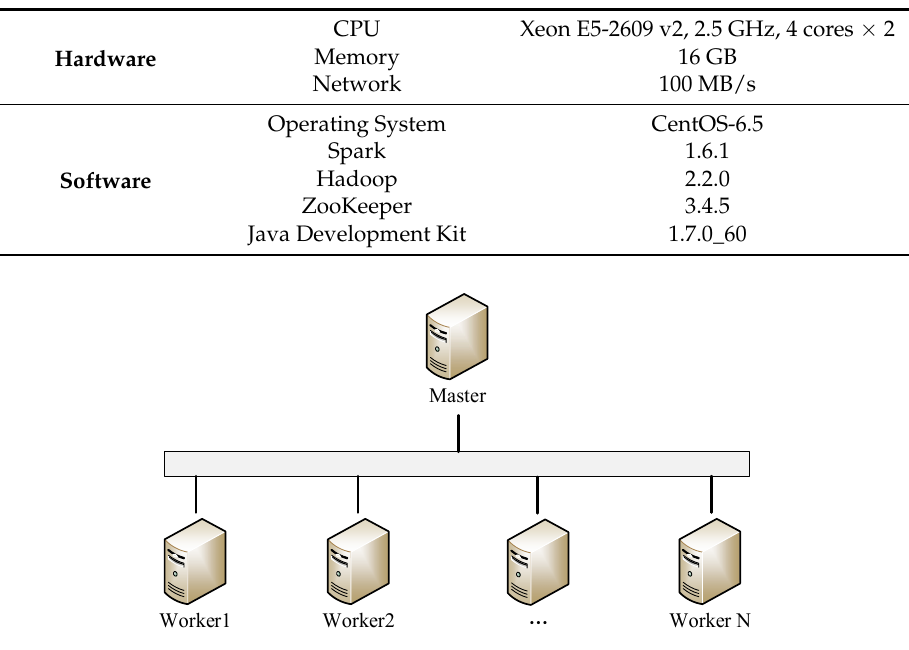
Figure 4. Network topology of our platform. As a stretchable platform, the number of workers is variable on demand.